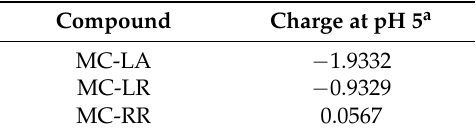
Table 1. Microcystin charge at experimental